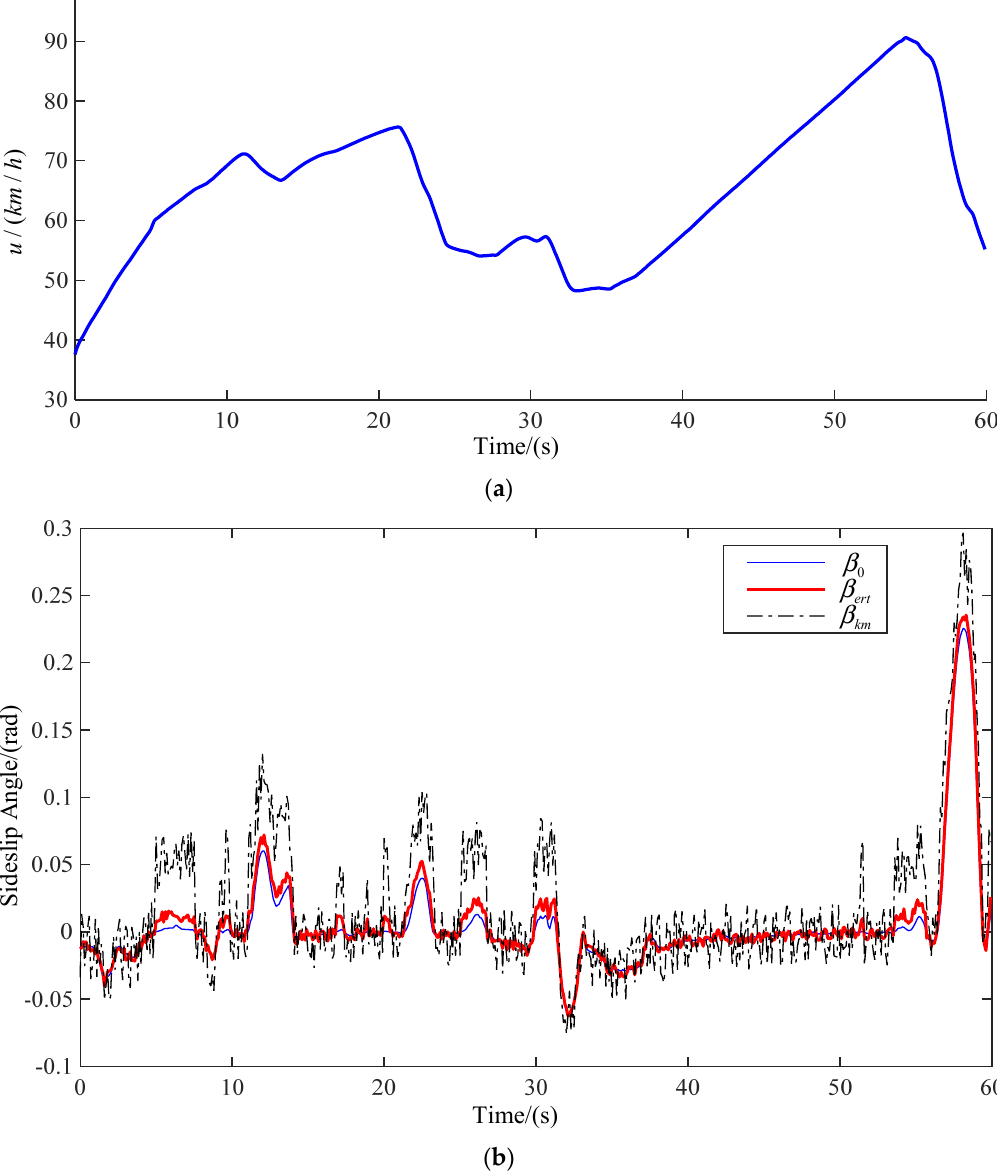
Figure 9. Medium and high speed ( a ) real-time speed; ( b ) estimation of sideslip angle. The actual vehicle sideslip angle β 0 , the observations of a common Kalman filter observer β km , and the observations of an EKF-based real-time observer β ert , are compared and analyzed in this article. The vehicle speed will decrease when turning, and the vehicle sideslip angle will change. The common Kalman filter observer yields good observation results only for a linear system, but the actual vehicle state parameter is a nonlinear system. Using a common Kalman filter observer to estimate the sideslip angle when the vehicle turns will produce a large error. At the same time, due to the essence of the Kalman filter, when the vehicle speed changes greatly and the sideslip angle changes greatly, the estimated data are closer to real values. The EKF-based real-time observer is an